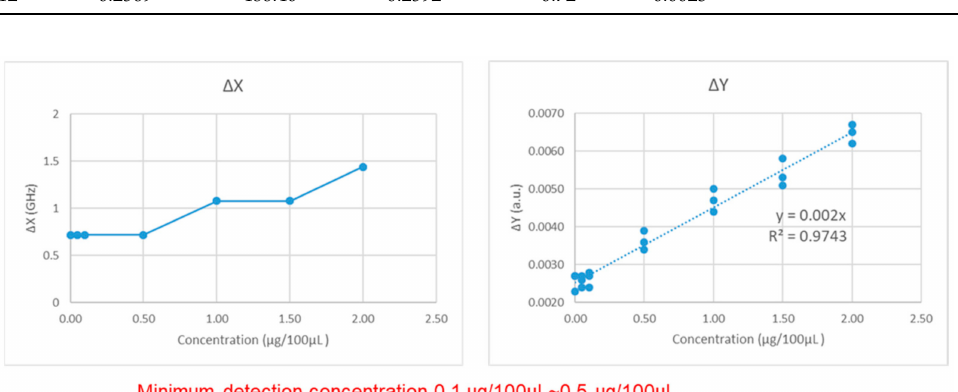
Figure 10. Relationship between the antigen concentration and ∆ X. ∆ Y by VDI